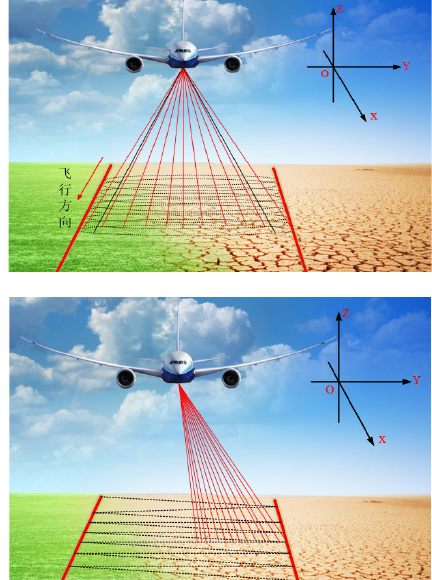
Figure 2: Two basic types of LiDAR scanning systems for point cloud data